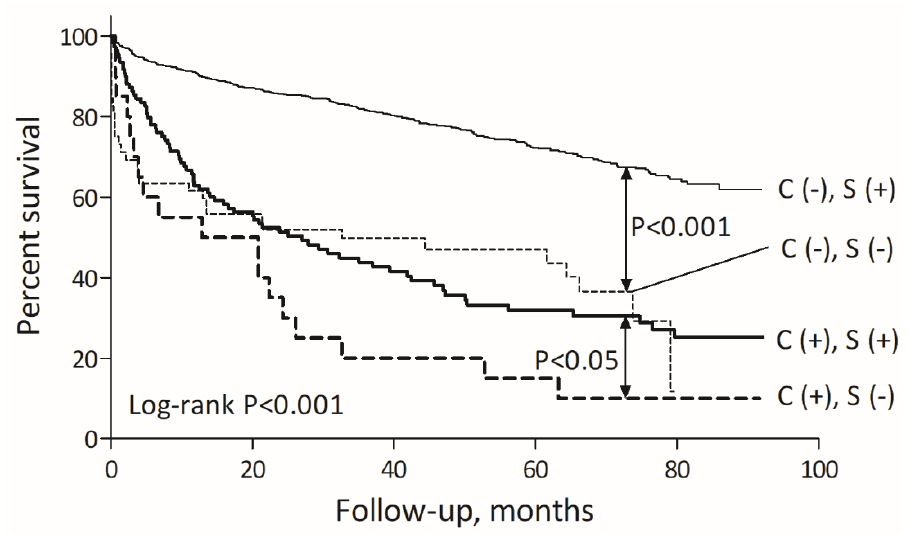
Figure 2. The impact of active cancer and statin usage on long-term mortality. Abbreviations: C: cancer, S: statin.